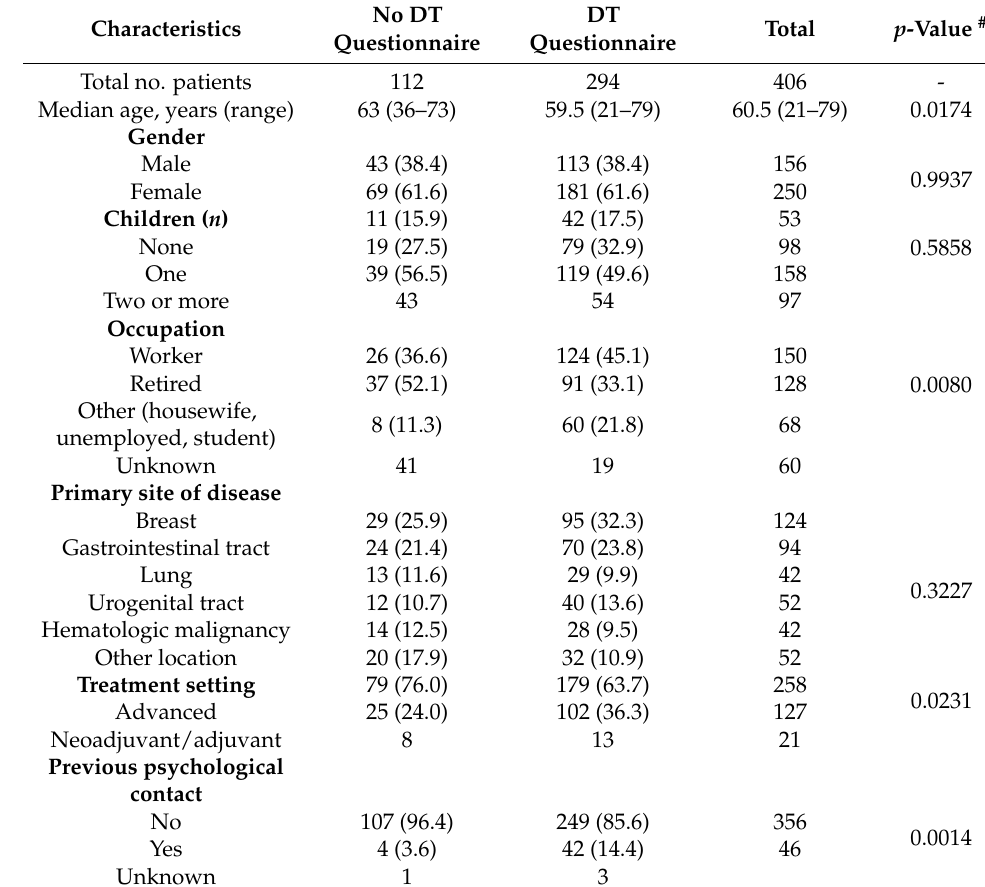
Table 1. Patient characteristics.